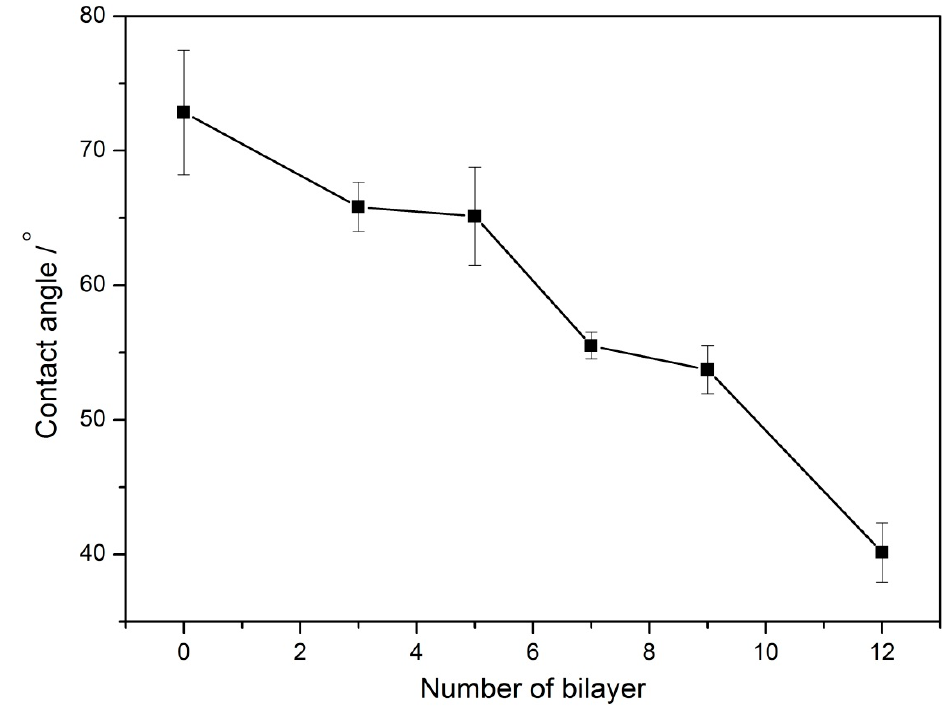
Figure 2. The static water contact angles ( θ c ) of the multilayer film (CNTs/PAH) n -deposited ITO electrodes.